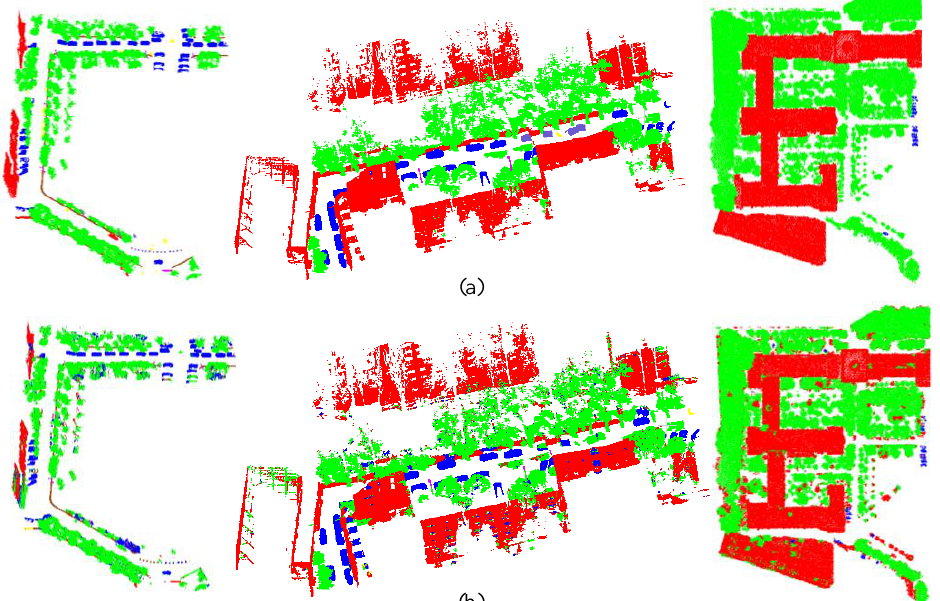
Figure 5. Classification results of the testing data. The first row shows the ground truth of the three testing sets; the second row represents the corresponding classification results with the proposed